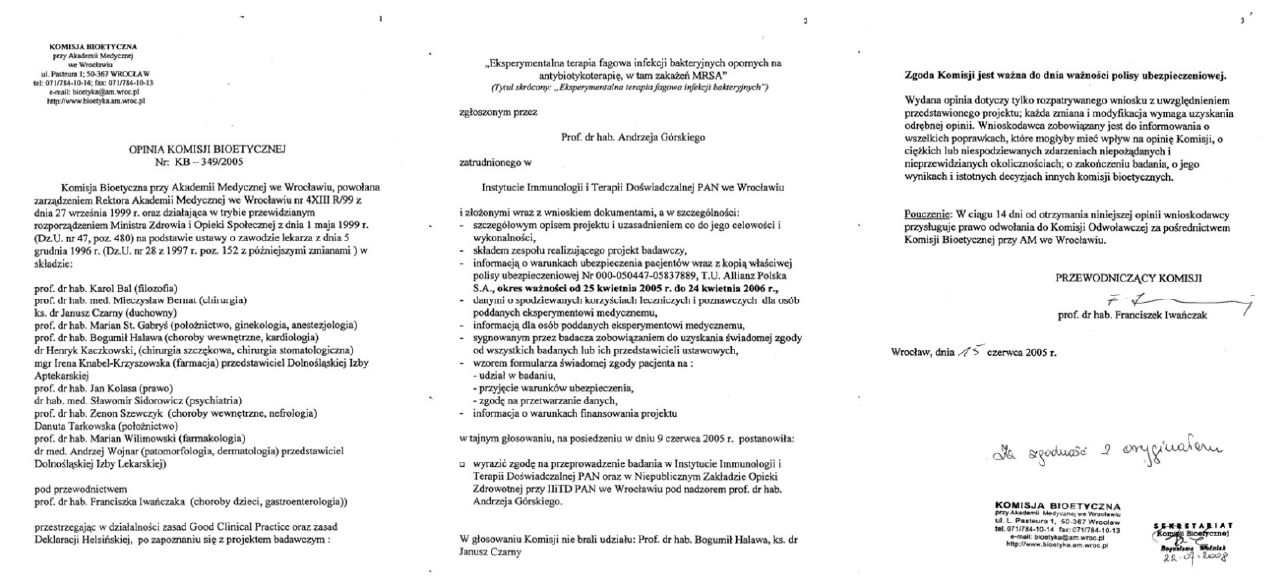
Figure 1. A decision dated 15 June 2005, authorizing the beginning of experimental phage treatment (officially named “Experimental phage therapy of drug-resistant bacterial infections, including MRSA infections”) at the PTU in Wrocław, Poland (in Polish).